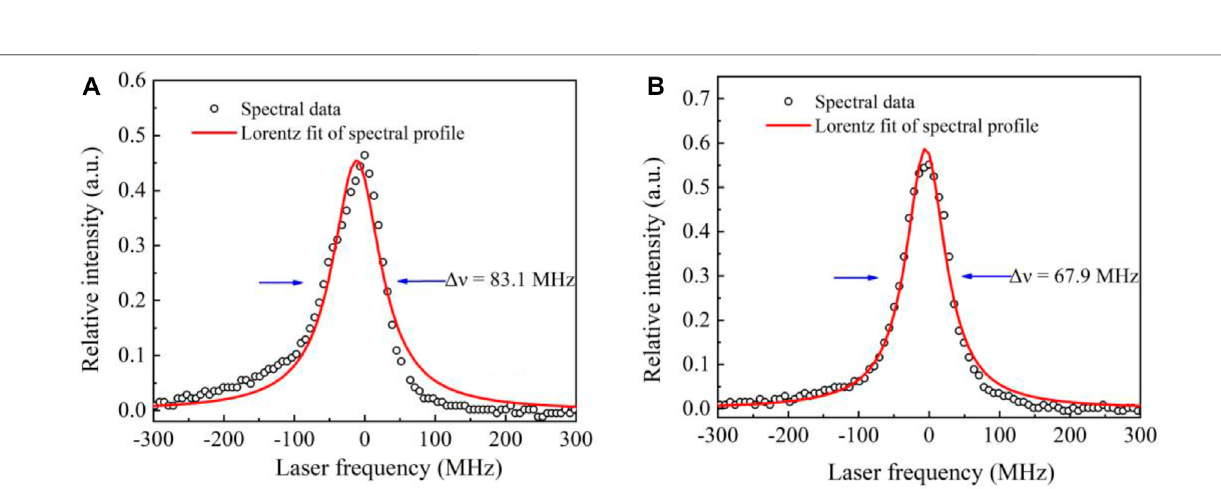
Frontiers in Physics |